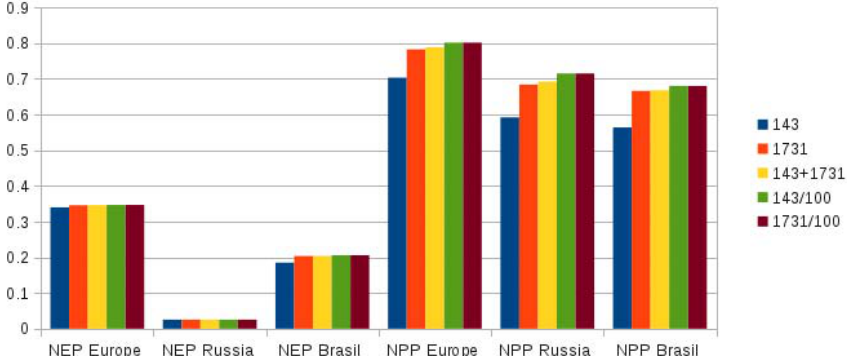
Fig. 5. Evaluation of two flux sites (blue and orange bars), of their combination (yellow bars), and of each site with data uncertainty reduced by a factor of 100 (green and brown bars): Uncertainty reduction for NEP and NPP integrated over three